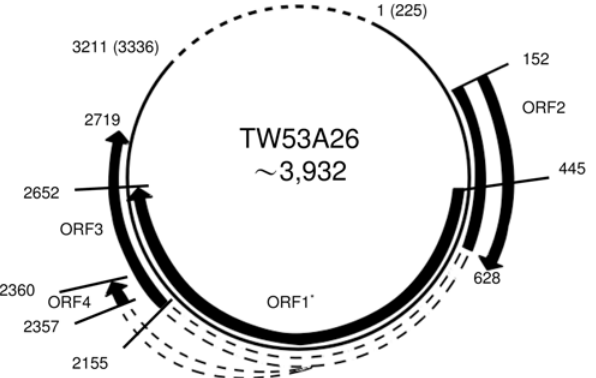
Fig 3. Putative genomic organization of TTV group 6 by using TW53A26 as representative isolate. ORFs are marked with black arrows. Predicted donor and acceptor sites are linked by dashed border. The dotted line indicated UTR that was not included in our ORF amplicon. ORF1 encoded for 736 amino acids (nt 445 – 2652), ORF2 for 159 amino acids (nt 152 – 628), ORF3 for 347 amino acids (nt 152 – 627 and 2155 – 2719), ORF4 for 160 amino acids (nt 152 – 627 and 2357 – 2360). The numbering of nt 1 (the first) and the nt 3211 (last nucleotide) of TW53A26 is according to nt 225 and nt 3336 of TA278, respectively. Numbers in bracket indicated the corresponding nucleotide position in TA278. The full length of TTV group 6 is about 3,932 nt calculated by assuming the UTR is conserved with Hel32, a strain with the same length of translated ORF1. * Since it is not included in consensus sequence, this group that a nonsense mutation of ORF1 at nt 523 of isolate TW53A26 is ignored